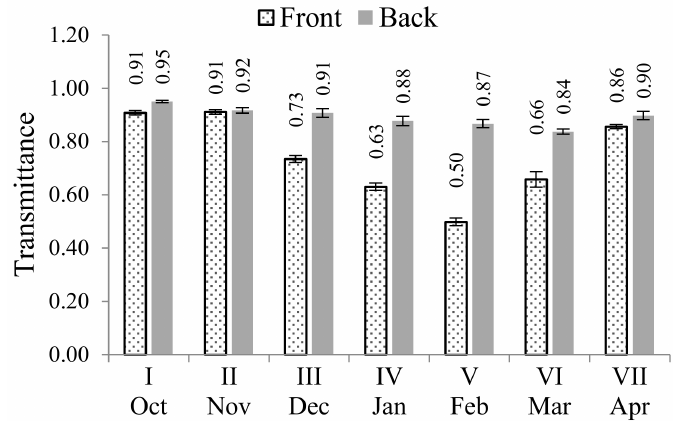
Figure 3. Transmittance of the front and back sides of the exposed glass